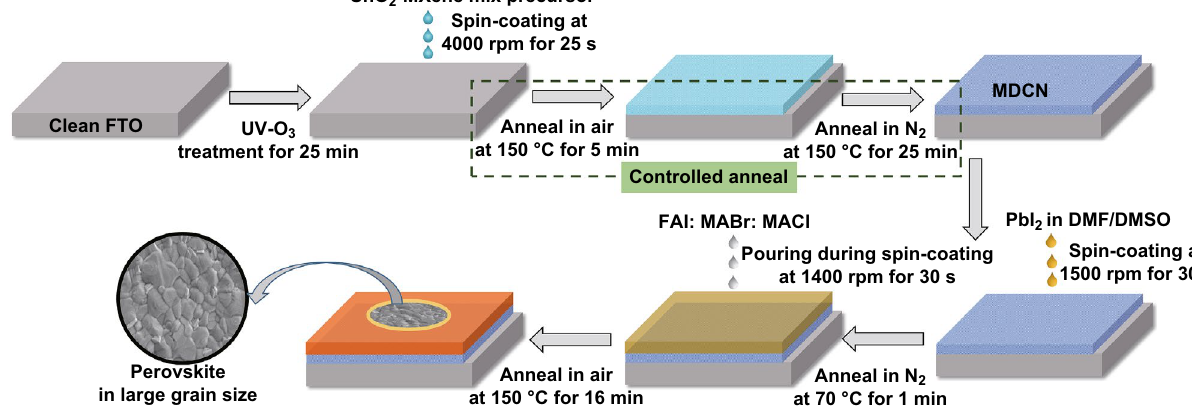
Fig. 1 Fabrication process for perovskite layer with MDCN